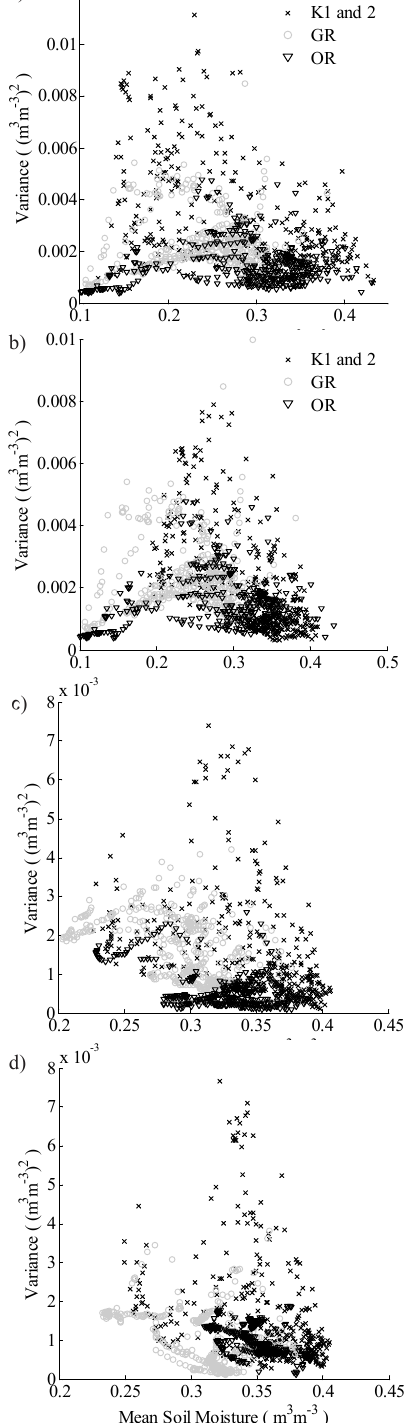
Fig. 7. Relationship between mean soil moisture and variance for the McMaster Mesonet sites at depths of (a) 10cm, (b) 20cm, (c) 30cm and (d)